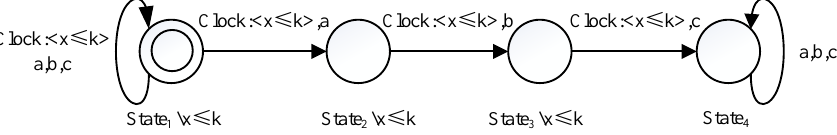
Figure 6. Property pattern of